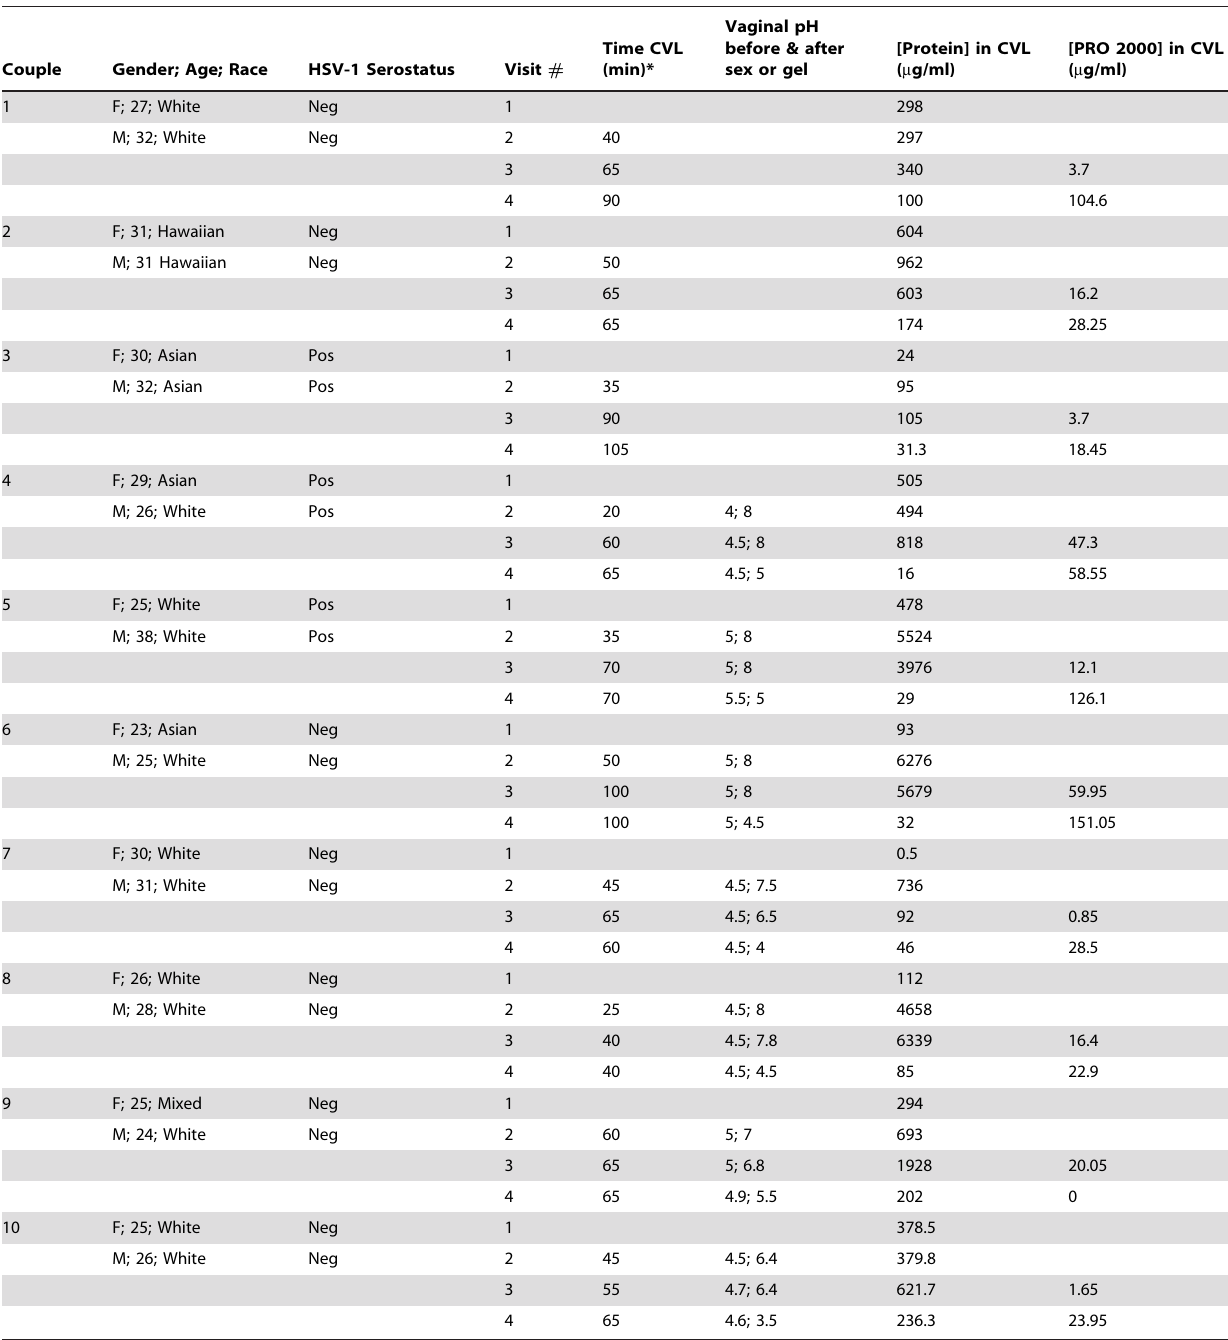
Table 1. Demographic and clinical data from 10